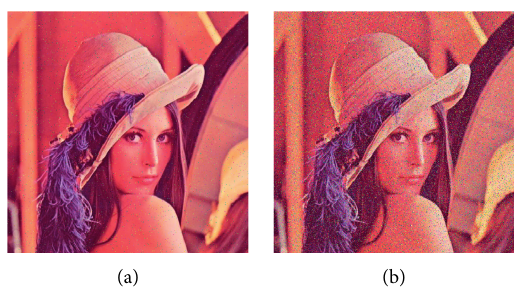
Figure 16: The decryption image with different densities of salt and pepper noise. (a) 0.05 and (b) 0.1.